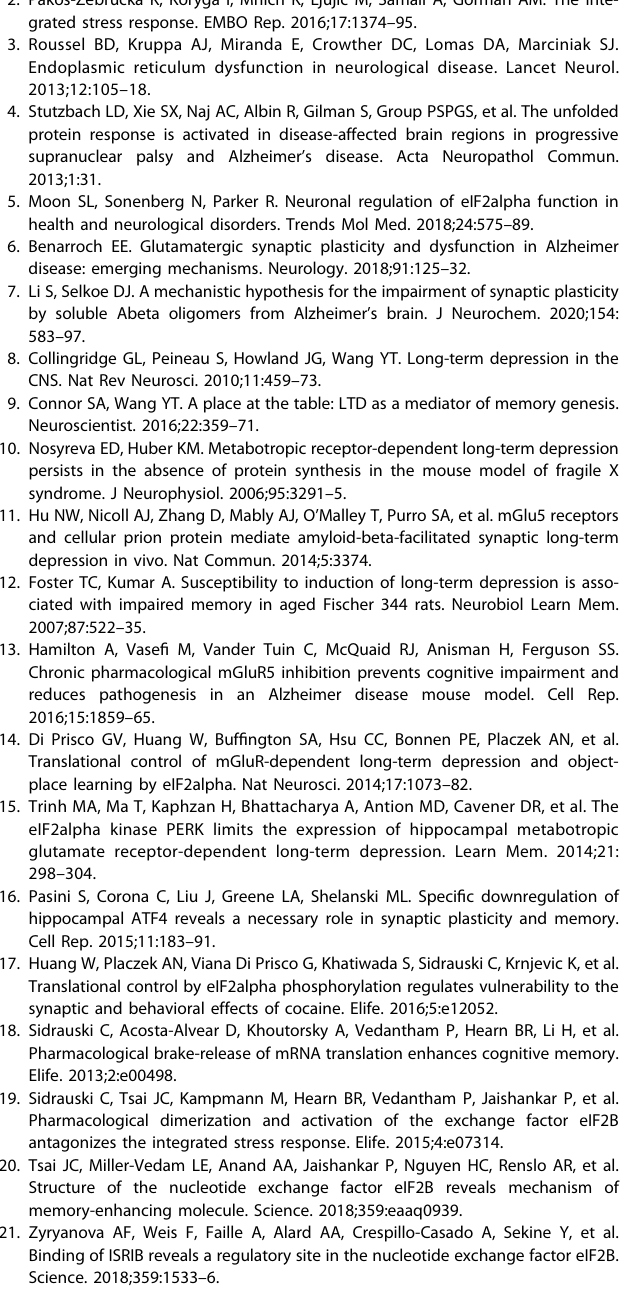
Fig. 4 Spatial learning and memory de fi cits in A β 1 – 42 -injected rats are abrogated by ISRIB using a weak MWM training protocol. A The timeline of experimental design. All animals were trained with 1-trial/day. Vehicle or ISRIB (0.25 mg/kg, i.p.) were injected immediately after the training session in the MWM every day. B All the rats spent less time gradually to fi nd the hidden platform after each training trial. A β 1 – 42 - injected rats spent more time to fi nd the hidden platform from day 6 and on day 14 and day 15 after one-week break ( n = 8 – 10 rats per group, Two-way ANOVA followed by a post hoc Bonferroni multiple comparison test, P < 0.0001, F 5,48 = 8.778. A β 1 – 42 + Veh versus Sham + Veh: P = 0.0681 on day 6, P = 0.0325 on day 14, P = 0.0415 on day 15; A β 1 – 42 + Veh versus A β 42 – 1 + Veh: P = 0.1142 on day 6, P = 0.0207 on day 14, P = 0.0410 on day 15) and ISRIB signi fi cantly improved performance (A β 1 – 42 + Veh versus A β 1 – 42 + ISRIB: P = 0.0146 on day 6, P = 0.0231 on day 14, P = 0.0158 on day 15). No difference was detected among Sham + Veh, A β 42 – 1 + Veh, Sham + ISRIB, A β 42 – 1 + ISRIB and A β 1 – 42 + ISRIB groups (Repeated measures ANOVA. P = 0.0569, F 4,41 = 2.504). C In the probe trial ( n = 8 – 10 rats per group), A β 1 – 42 -injected animals crossed the platform much less compared with control groups (A β 1 – 42 + Veh versus Sham + Veh: P = 0.0129; A β 1 – 42 + Veh versus A β 42 – 1 + Veh: P = 0.0028) and ISRIB signi fi cantly enhanced platform crossing in A β 1 – 42 -injected rats (A β 1 – 42 + Veh versus A β 1 – 42 + ISRIB: P = 0.0050, One-way ANOVA followed by a post hoc Bonferroni multiple comparison test). D – F All the groups were similar in target quadrant occupancy ( P = 0.9409, One- way ANOVA) ( D ) and total swimming distance ( P = 0.7056, One-way ANOVA) ( E ) and swimming speed ( P = 0.7876, One-way ANOVA) ( F ). Error bars, s.e.m.